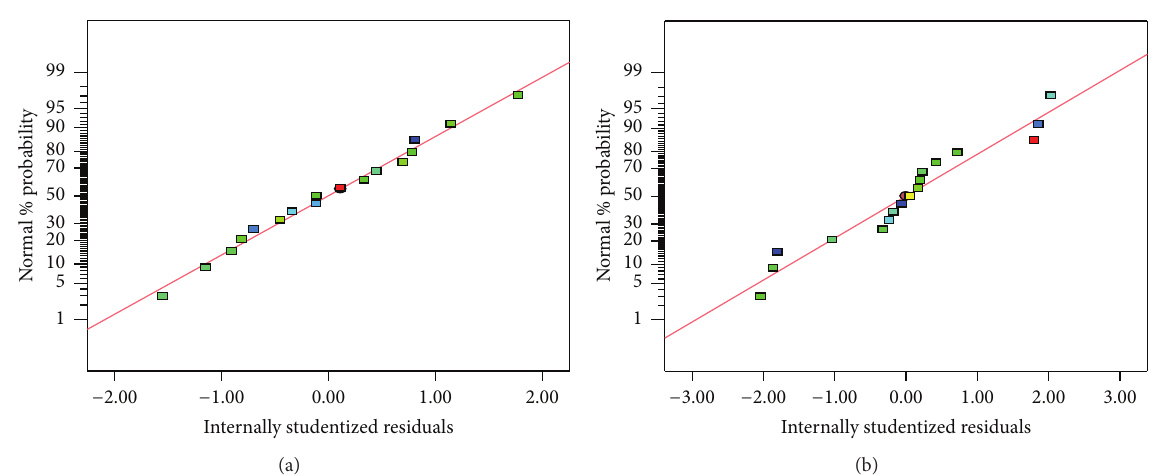
Figure 1: Normal probability plots of residuals for (a) methanolic extraction and (b) ethanolic